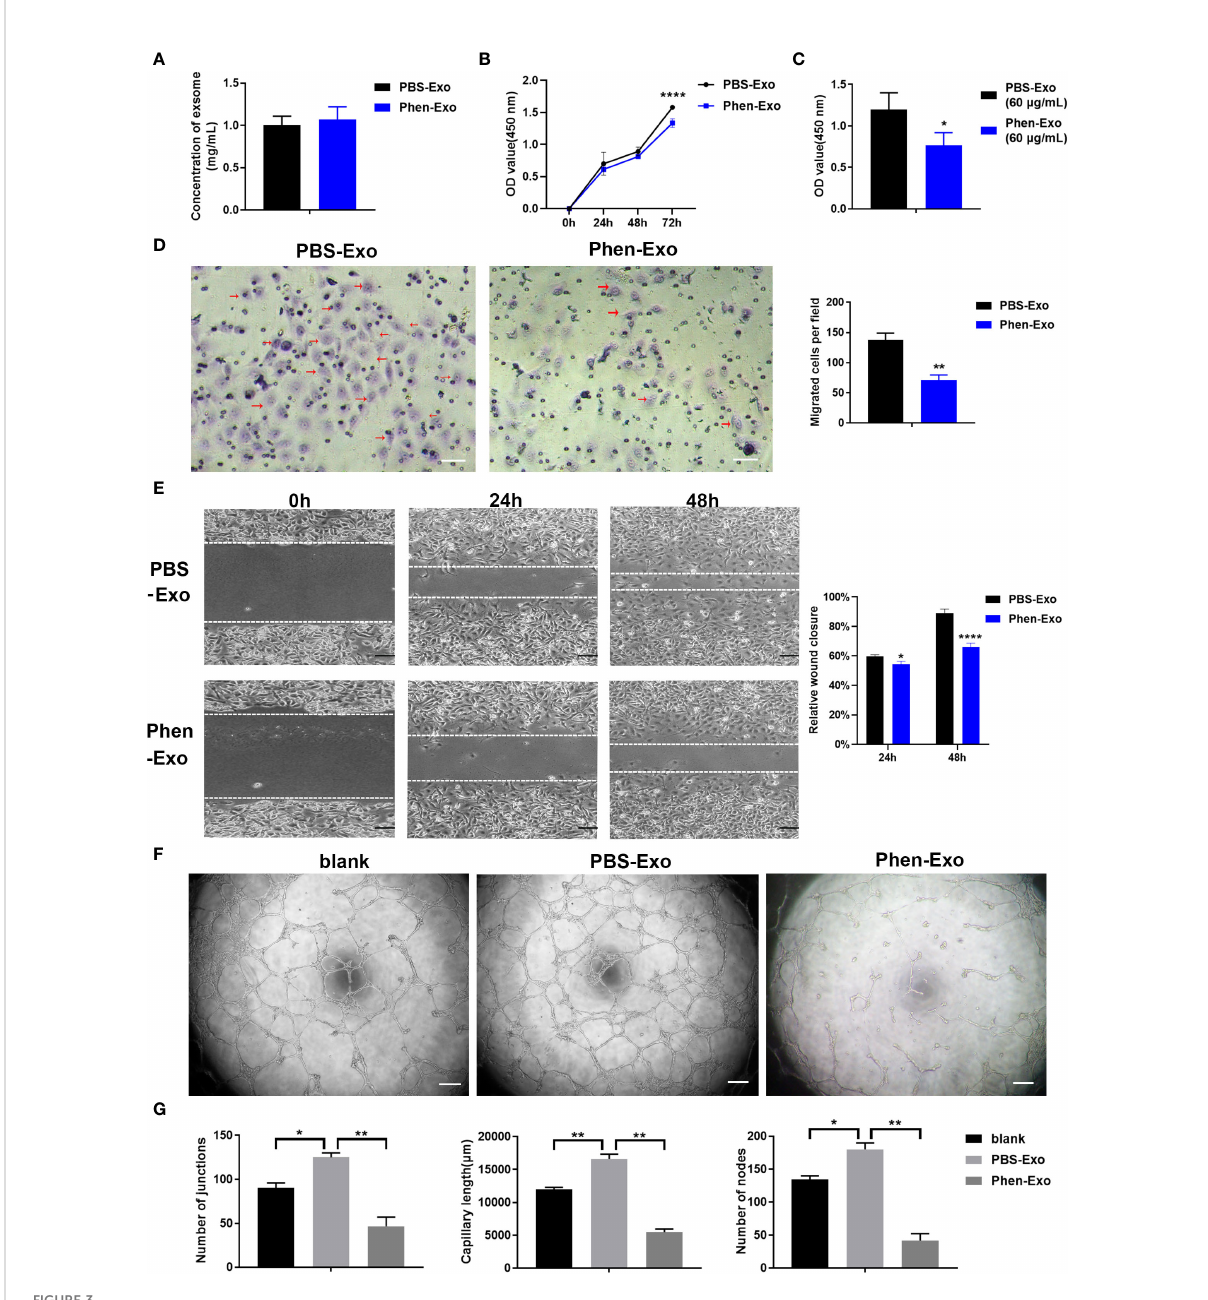
FIGURE 3 Exosomes derived from OSCC cells treated with phenformin (Phen-Exo) inhibit the proliferation, migration and tube formation of vascular endothelial cells in vitro . (A) The concentration of exosomes extracted from the conditioned medium of CAL 27 cells treated with PBS (PBS-Exo) or Phenformin (Phen-Exo) measured using a BCA protein quantitation kit. (B) HUVECs were treated with PBS-Exo (30 m g/mL) or Phen-Exo (30 m g/mL), then were collected at the different time points indicated and analyzed by the CCK8 assay for cell viability. (C) HUVECs were treated with PBS-Exo (60 m g/mL) or Phen-Exo (60 m g/mL), then were collected at 72 h and analyzed by the CCK8 assay for cell viability. (D) (Left) images of migrated HUVECs (red arrows) through membranes at 24 h after treatment with PBS-Exo (30 m g/mL) or Phen-Exo (30 m g/mL). Scale bars = 50 m m, and (Right) quanti fi cation of the number of migrated cells per fi eld. (E) (Left) images of HUVECs cultured with PBS-Exo (30 m g/ mL) or Phen-Exo (30 m g/mL) at 0 h, 24 h and 48 h after scratching. Scale bars = 200 m m, and (Right) bar graph of quanti fi cation of the rate of scratch closure (%). (F) Matrigel tube formation assay of HUVECs treated with PBS (blank), PBS-Exo (30 m g/mL) or Phen-Exo (30 m g/mL). Scale bars = 200 m m. (G) Quanti fi cation of junctions, capillary length and nodes in the network structures of HUVECs in (F) . All experiments were performed three times, and error bars represent means ± SD in each group; P values are indicated with “ * ” , * indicates P<0.05, ** indicates P<0.01, **** indicates